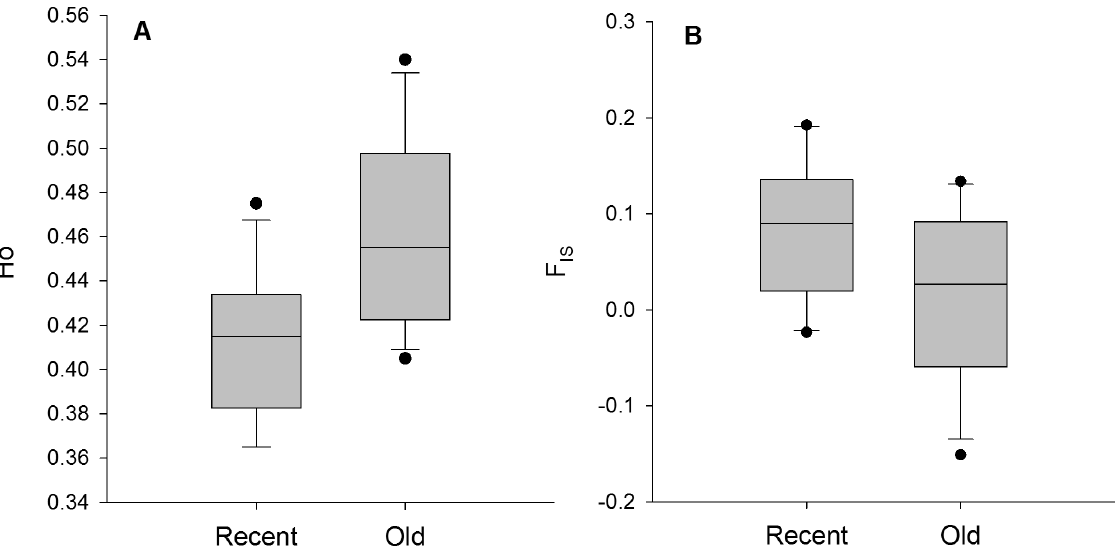
Figure 3. Difference in observed heterozygosity and inbreeding coefficient between recent and old populations. A. Boxplot for observed heterozygosity (H O ). B. Boxplot for inbreeding coefficient (F IS ).